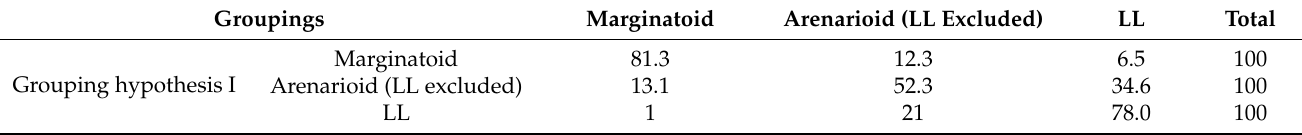
Table 6. Confusion matrix of the LDA based on the seed morpho–colorimetric dataset (percentages of correct classification), according to the alternative grouping hypotheses I and II for Armeria arenaria populations. Rows show the membership of each a priori established group, whereas columns show the membership predicted by the classification